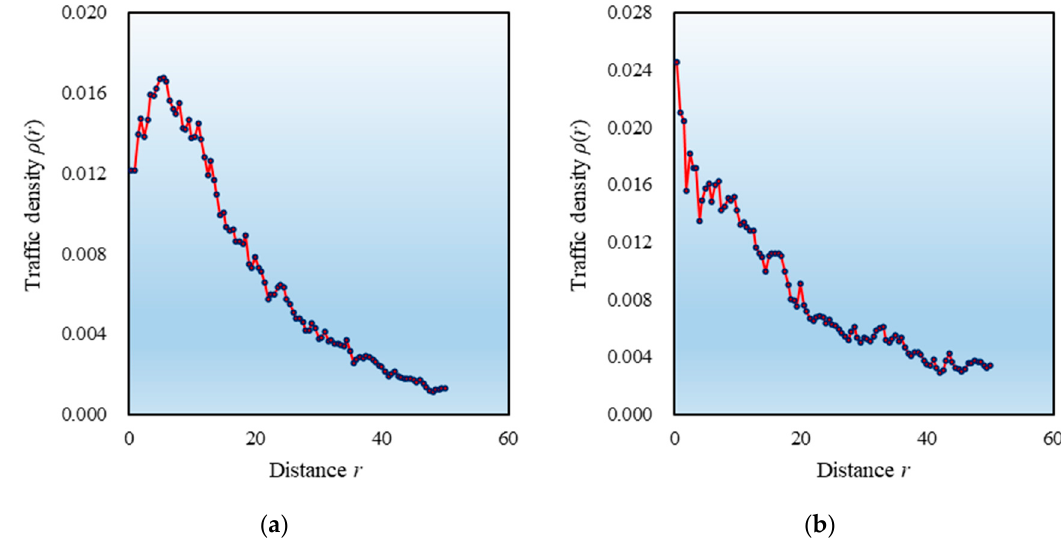
Figure 4. The patterns of traffic network density distributions of Beijing and Shanghai cities (2016). ( a ) Beijing; ( b ) Shanghai. Note: The spatial signals can be turned into density curves of urban traffic networks by using Equation (14). If the density data could be fitted to an inverse power law, we should estimate fractal dimension directly by means of Equation (1). Due to the curves depart from power function, we had to employ the wave-spectrum scaling analysis to estimate fractal dimension.